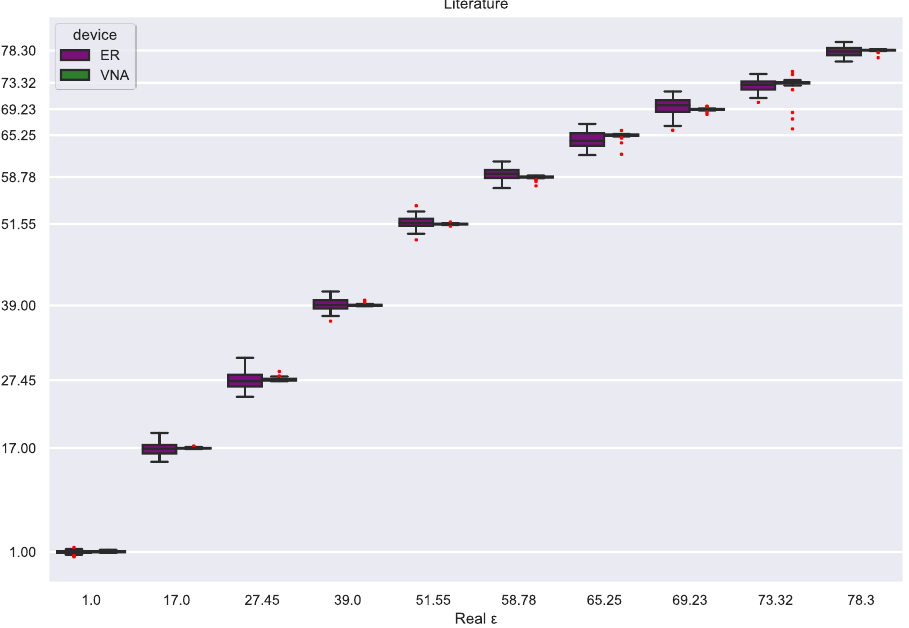
Figure 14. Permittivity estimations for both devices from an SVR model trained with the permittivity values found in the literature [23].